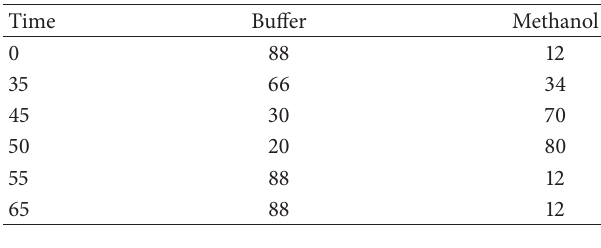
Figure 3: Blank run at 278 nm.